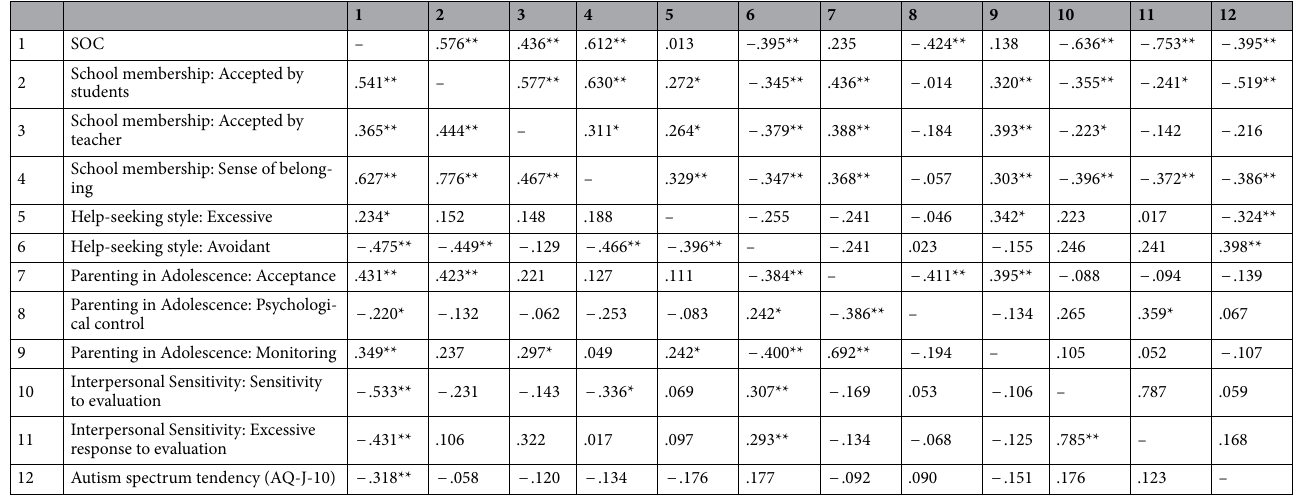
Table 4. Students’ correlation coefficient by gender. SOC sense of coherence. * p < 0.05, ** p <